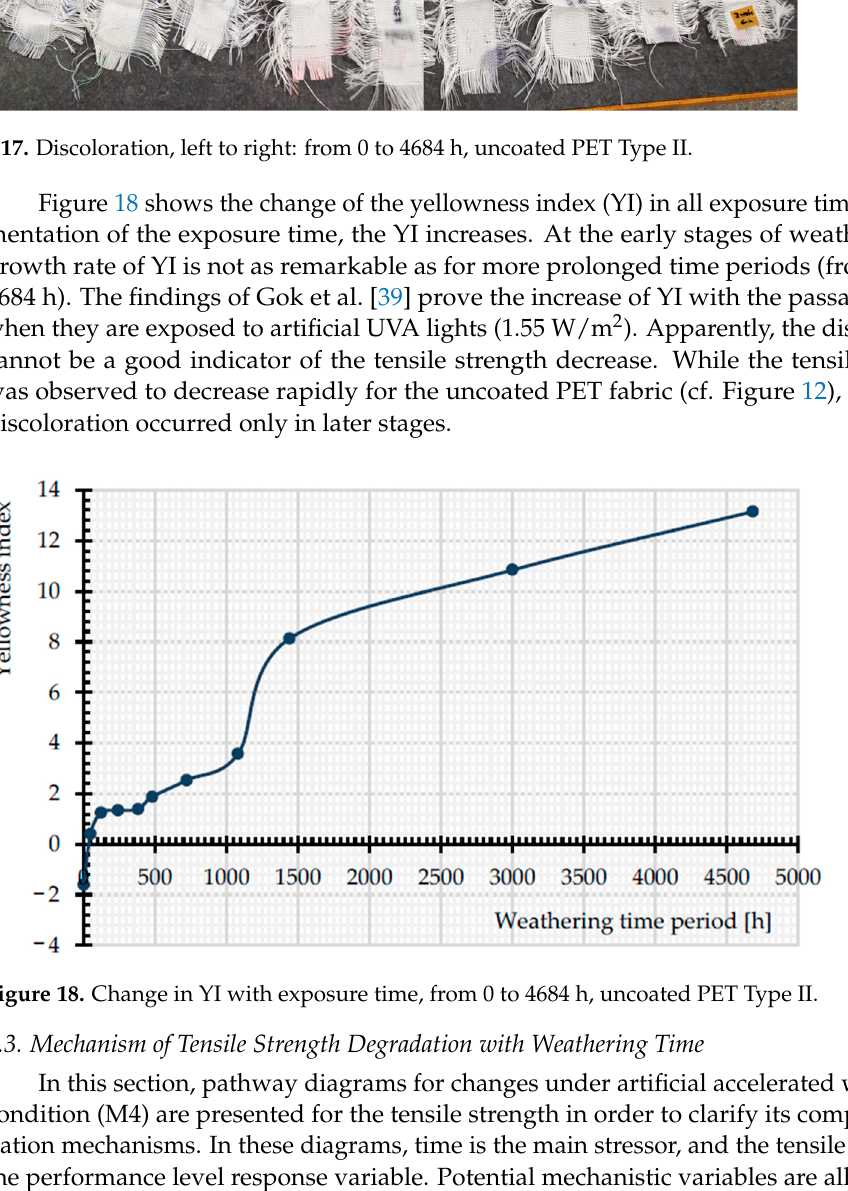
Figure 17. Discoloration, left to right: from 0 to 4684 h, uncoated PET Type II.